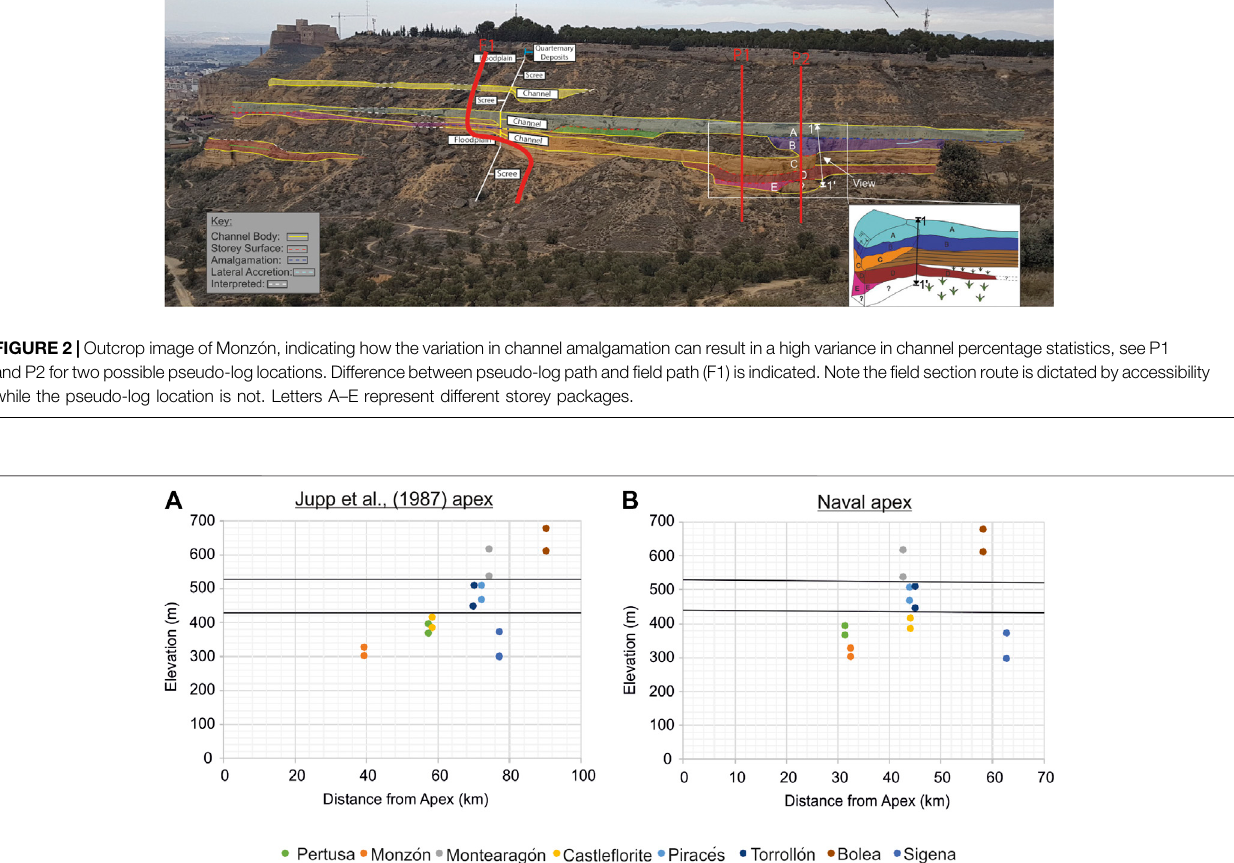
Frontiers in Earth Science |